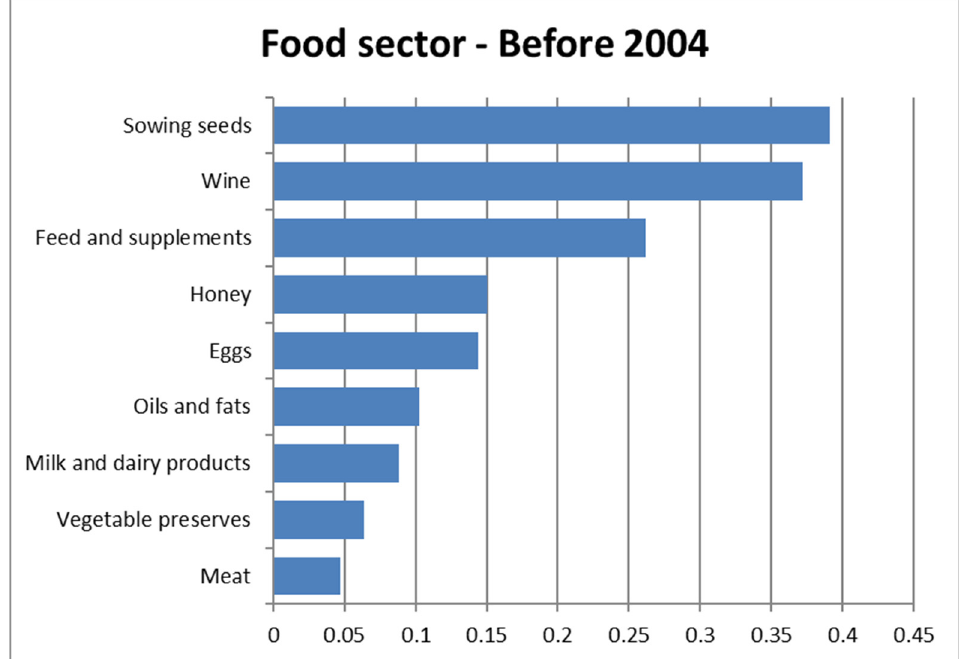
Figure 3. Ranking of food sectors before 2004.